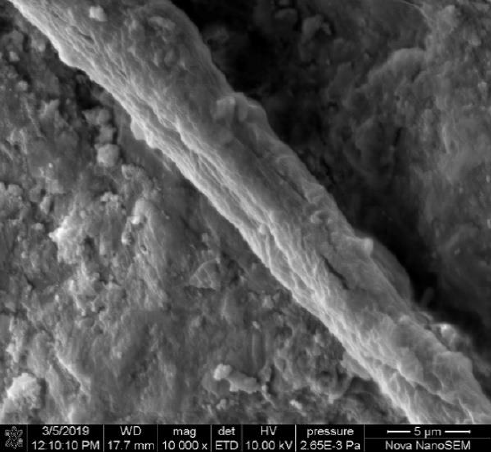
Figure 4. SEM micrograph of a PE fiber in cementitious composites [108].